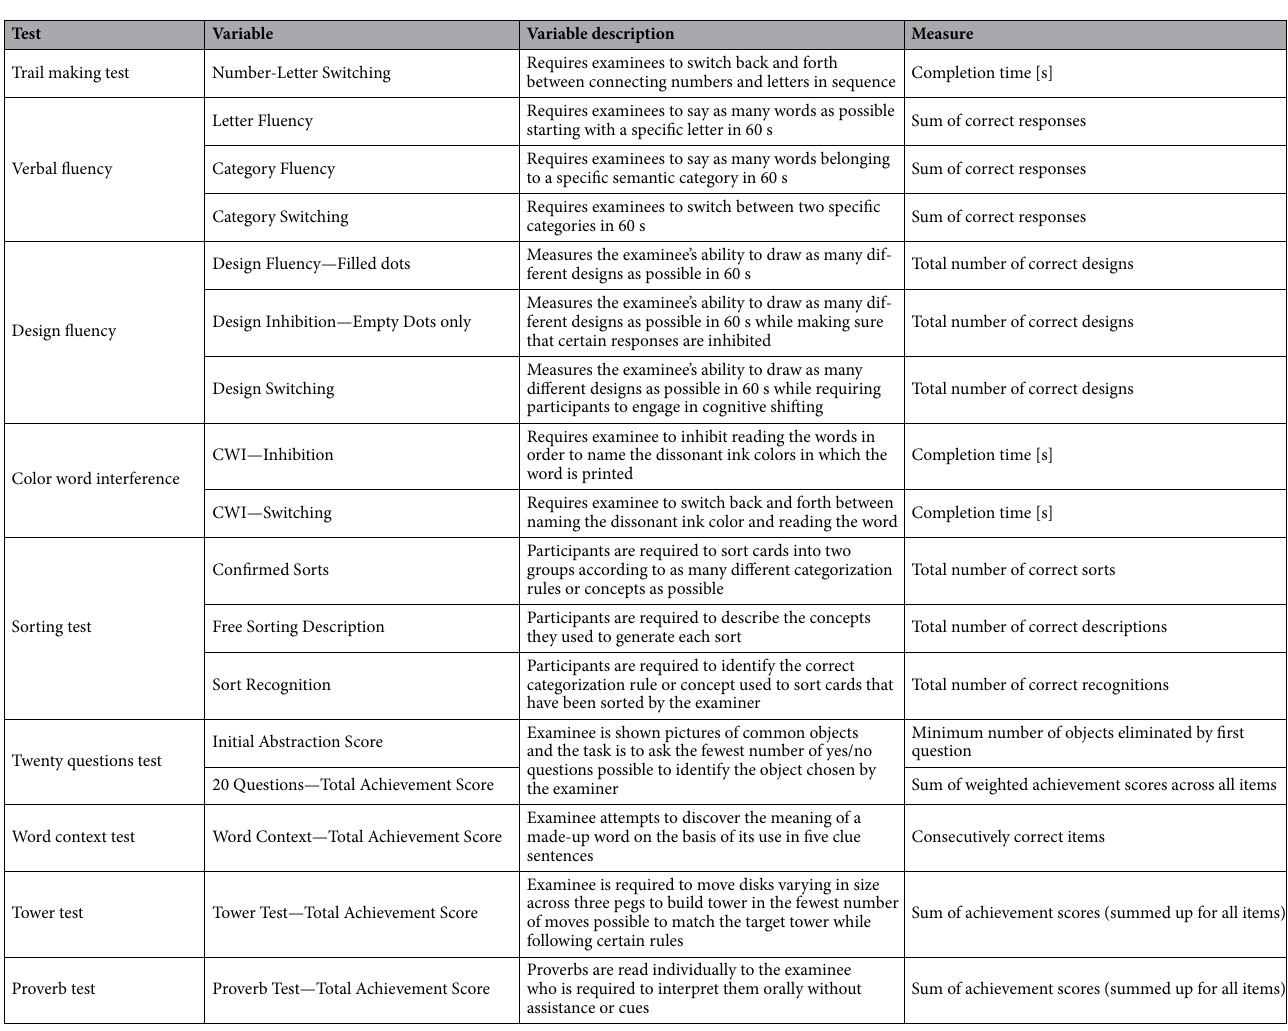
Table 1. Description summary of all variables included in the